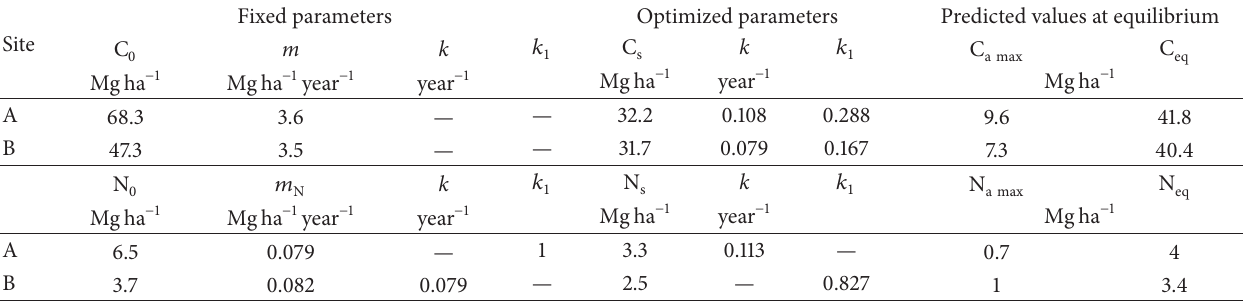
Table 4: Values of model parameters (C s , 𝑘 , and 𝑘 1 ) obtained with the AMG model in sites A and B.